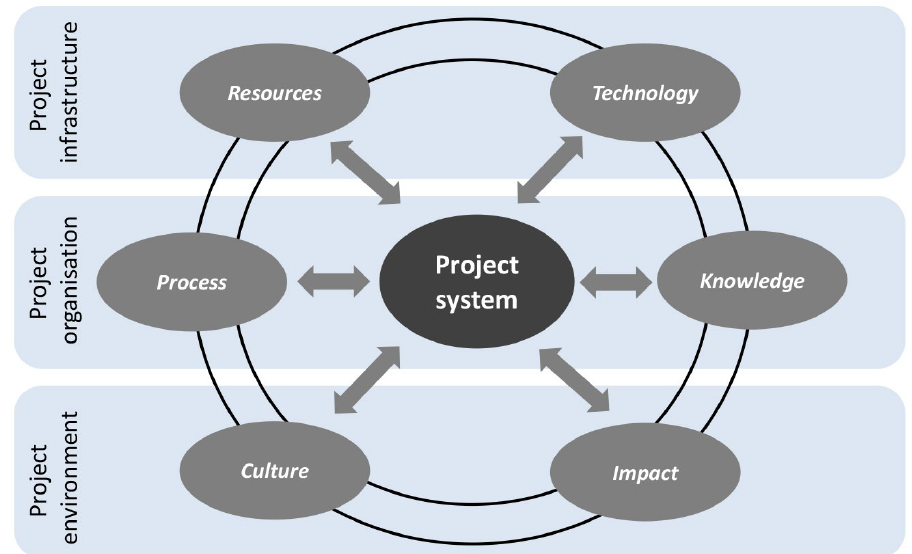
Figure 1. Conceptual model for integrated systems view of